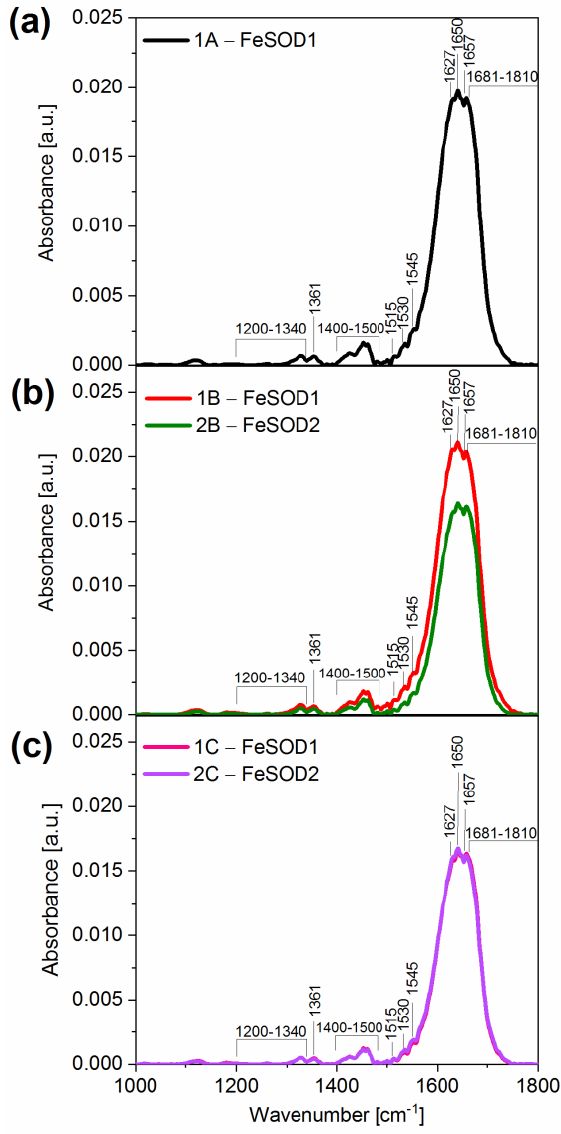
Figure 3. Fourier transformed infrared (FTIR) spectroscopy spectra of the bands of SOD, excised from the gel (see “Materials and Methods” and Figure 2). ( a ) Band 1A of Synechocystis sp. PCC 6803, ( b ) Bands 1B and 2B of Gloeobacter violaceus , and ( c ) Bands 1C and 2C of Geitlerinema sp. ZHR1A. These spectra are representative of three independent measurements.